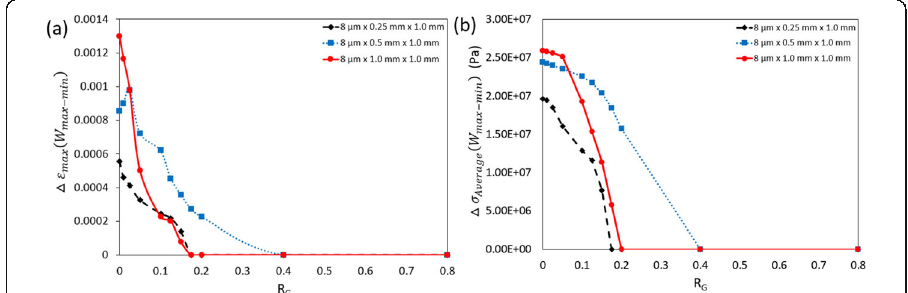
Fig. 11 Difference in spatially maximum strain and average stress as a function of disorder strength and maximum and minimum crack width: ( a ) the difference in the maximum strain of the notch width of 16 μ m as a function of disorder ( b ) the difference in the peak average stress of the notch width of 0.5 mm as a function of